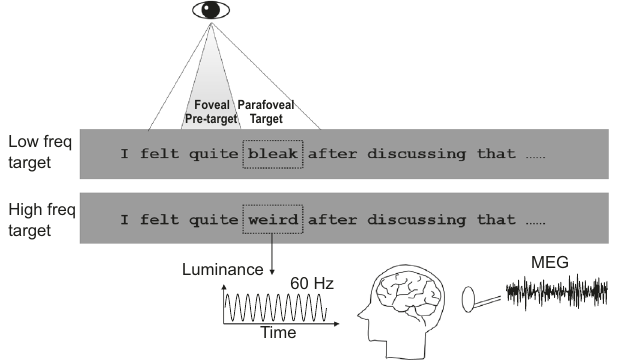
Fig. 1 The reading task. Participants ( n = 39) read sentences silently, while eye-movements and brain activity were recorded. Each sentence contained either a low or high lexical frequency target word (see dashed rectangle; not shown in the experiment). A Gaussian smoothed patch beneath the target word was fl ickered at 60 Hz continuously when the sentence was on the screen. This allowed us to measure neural responses associated with lexical parafoveal using rapid invisible frequency tagging (RIFT). One- quarter of the sentences were followed by a simple yes-or-no carefully. Freq frequency.